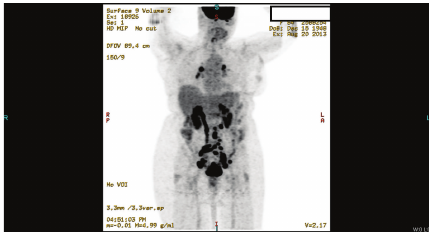
Figure 3: PET CT scan showing cervical mass, consistent with car- cinoma, with diffuse lymphadenopathy throughout the abdomen, pelvis, and the hila of both lungs.